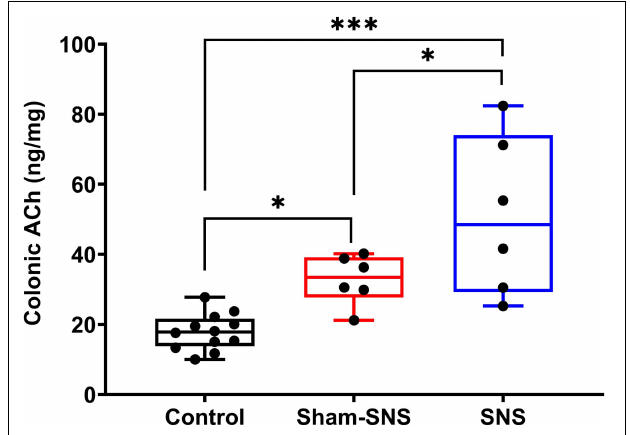
FIGURE 5 | Effects of chronic SNS and sham-SNS on colonic ACh release. ACh in colon tissues was significantly increased in SNS group. Values were represented as the means ± SE (control: n = 6, SNS and sham-SNS: n = 6). SNS, sacral nerve stimulation (* p < 0.05, *** p < 0.0001; One-Way ANOVA,